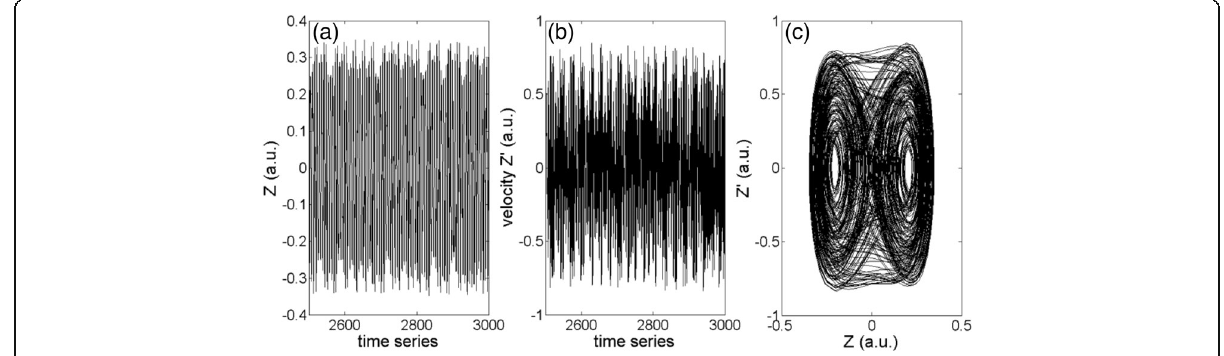
Fig. 7 a Vibration amplitude versus time. b Velocity versus time. c Phase portrait. μ 0 = 0, V ac = 21 V, and ω 1 =